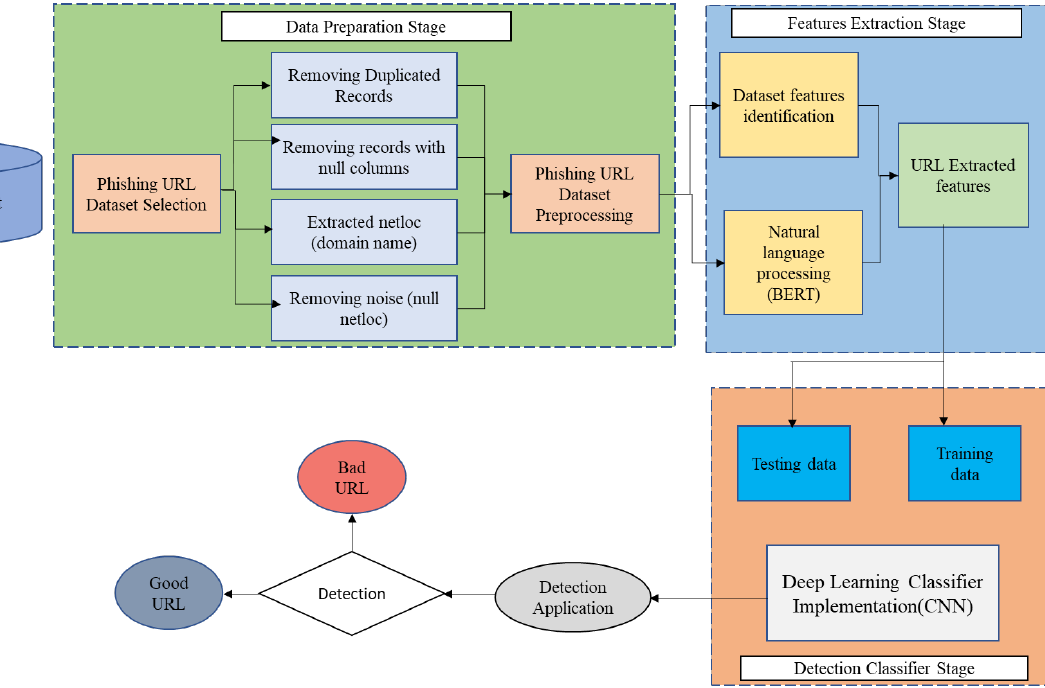
Figure 4. Block diagram of the proposed method.